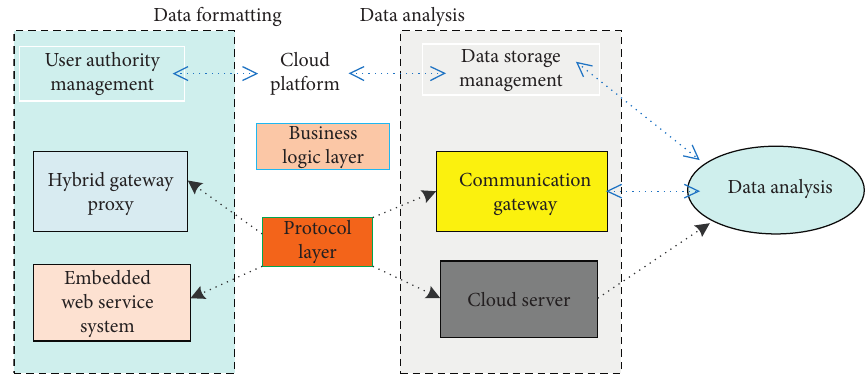
Figure 1: Existing process of microbial concentration detection in